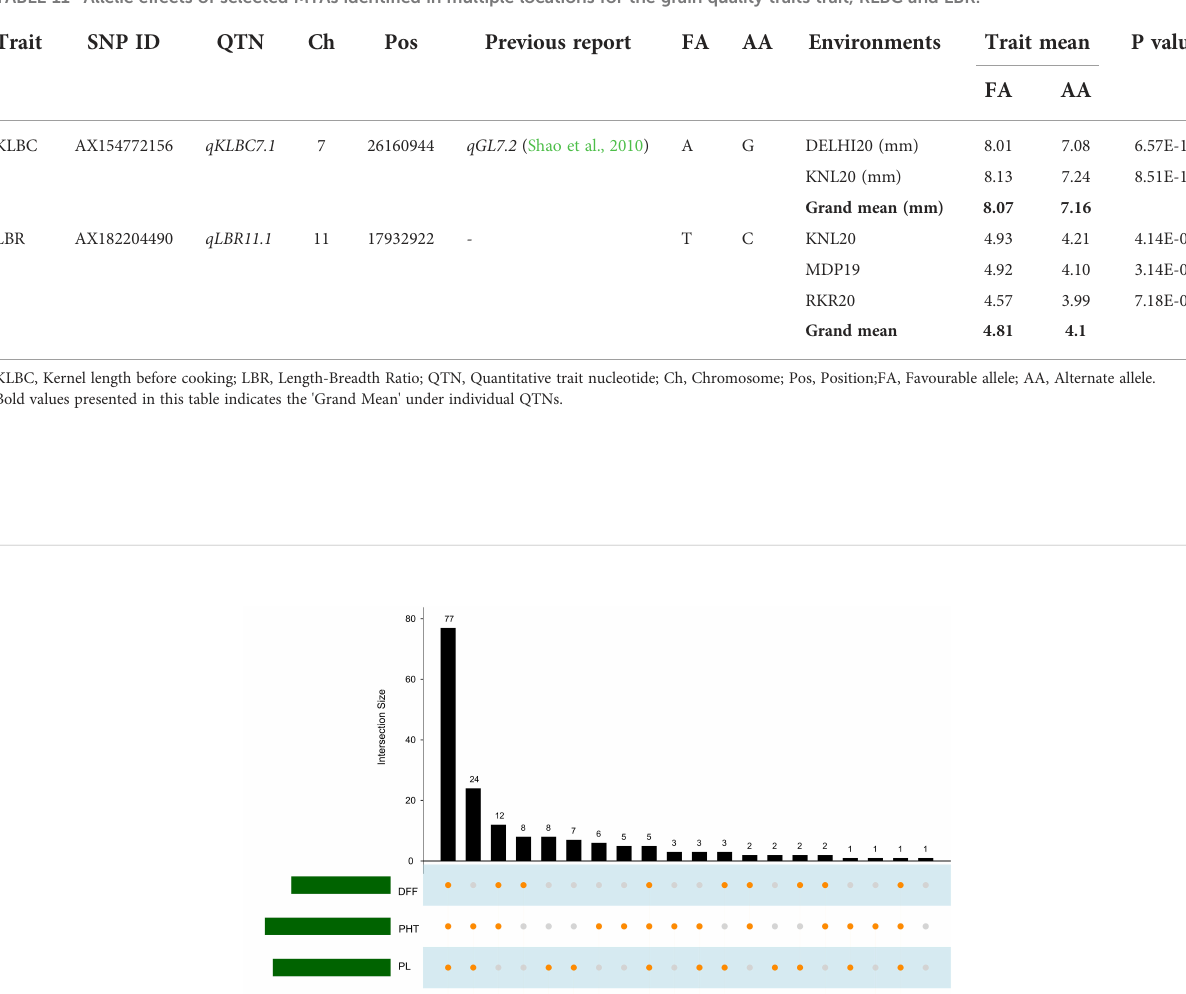
TABLE 11 Allelic effects of selected MTAs identi fi ed in multiple locations for the grain quality traits trait, KLBC and LBR.